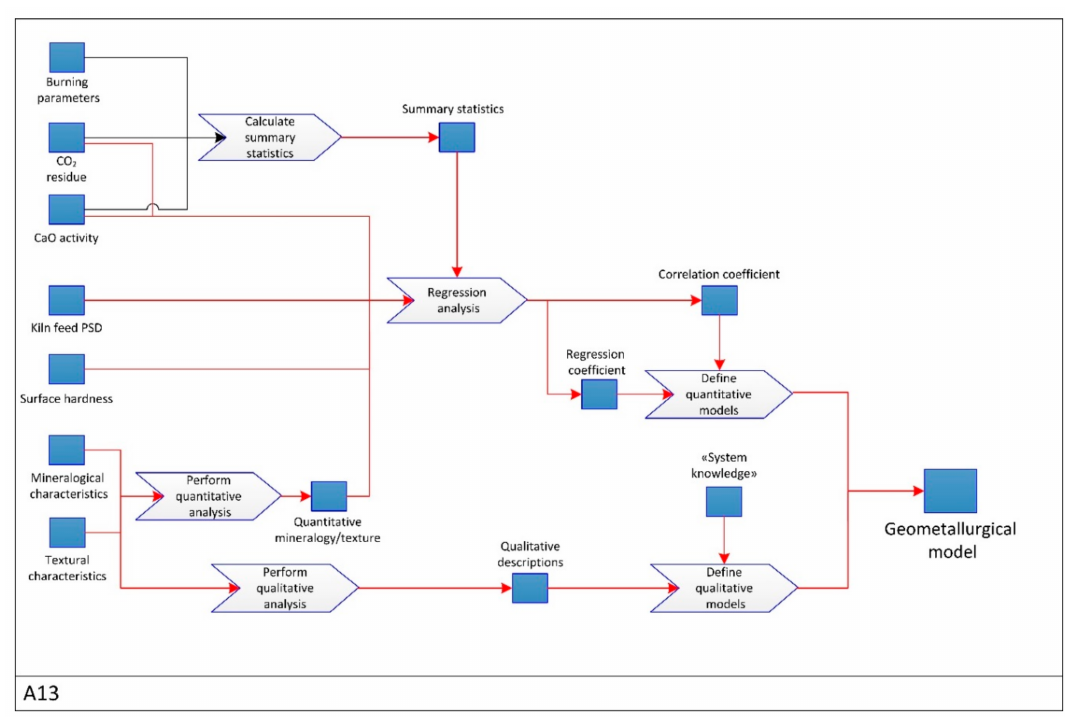
Figure 9. The Develop equations function detailed as a child